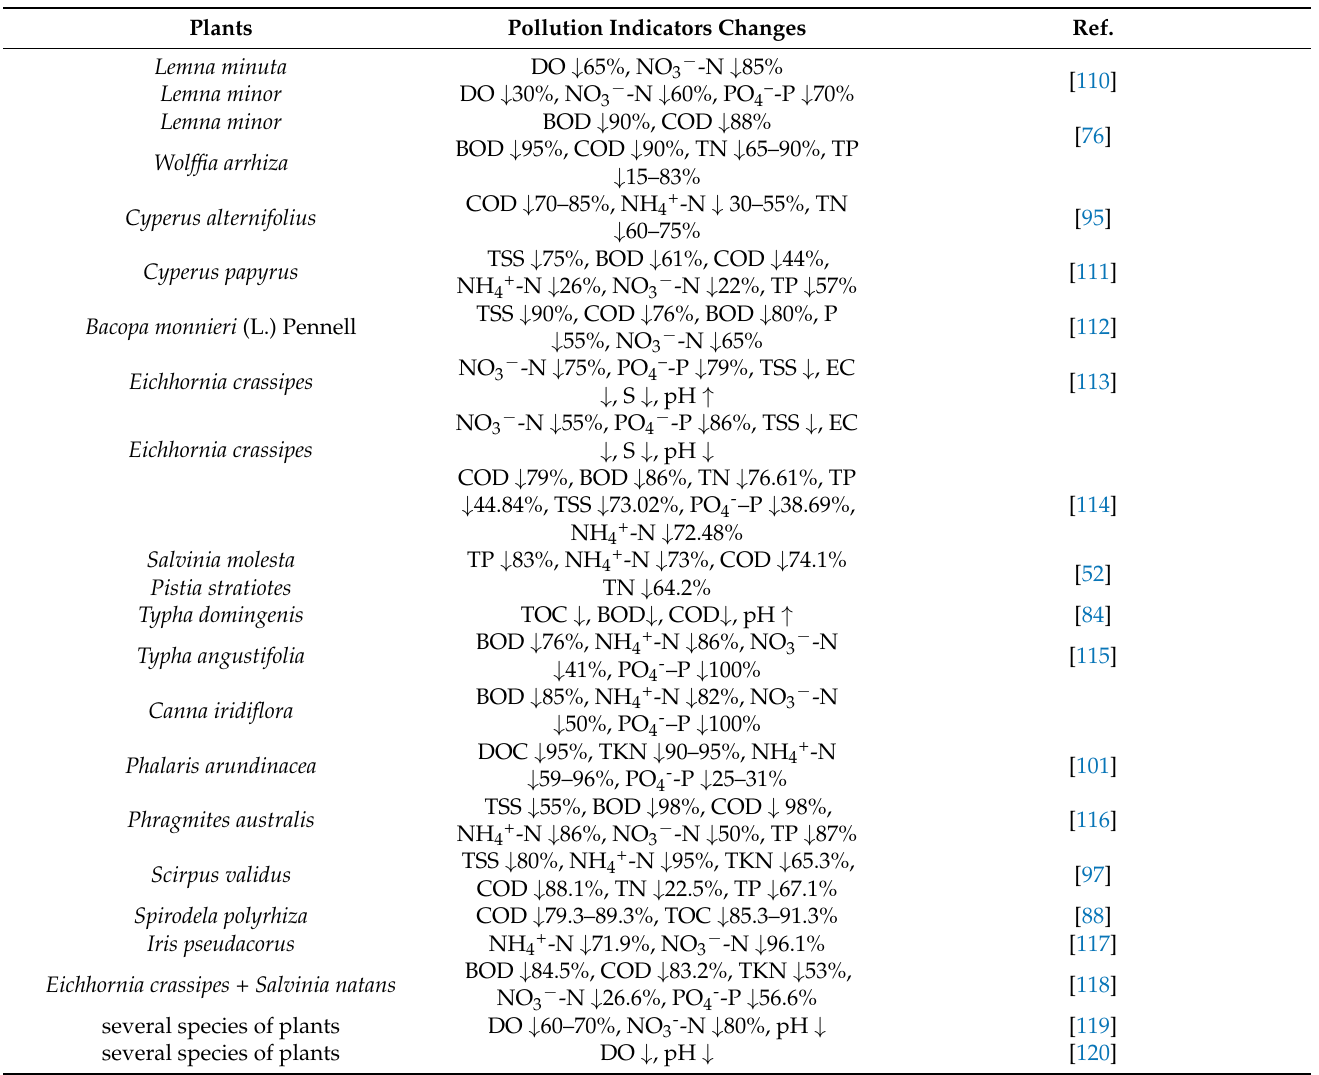
Table 4. The influence of plants growth on the general pollution